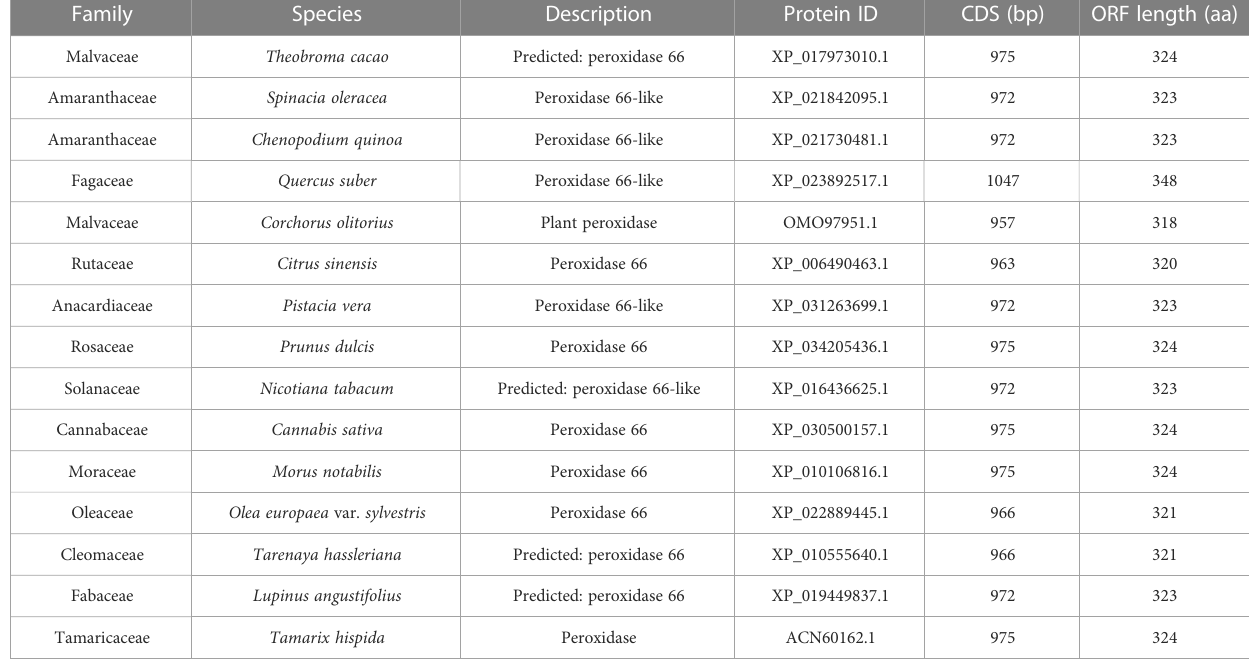
TABLE 2 Information sheet for 15